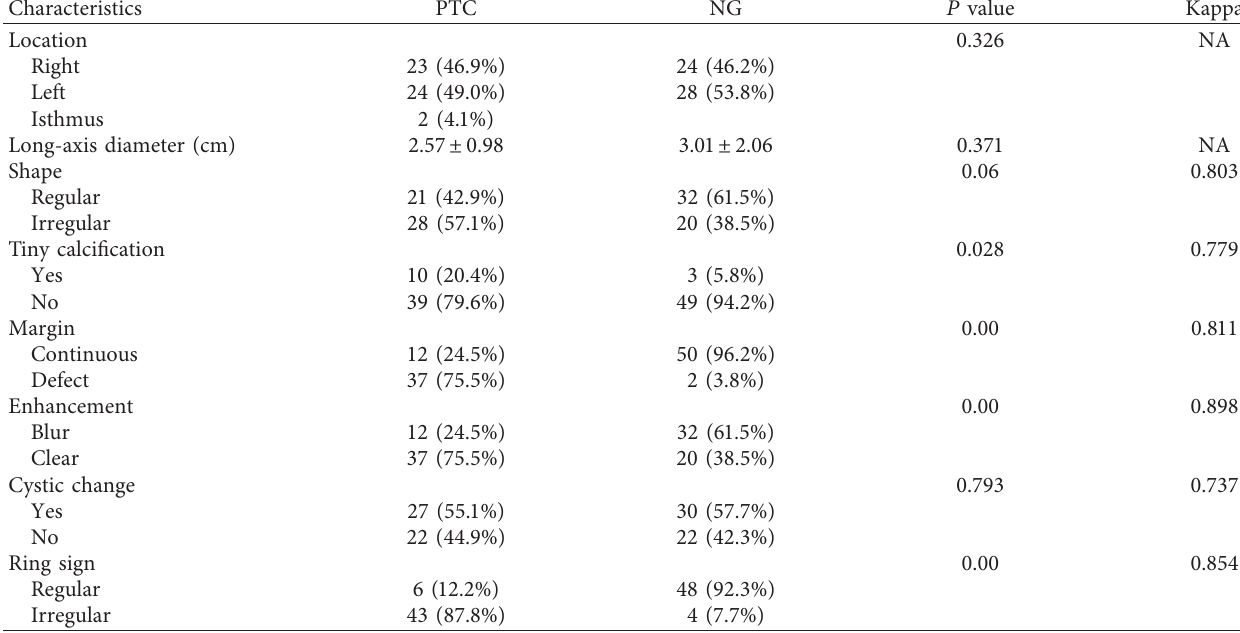
Table 2: Univariate analysis of the characteristics and imaging signs of thyroid nodules.